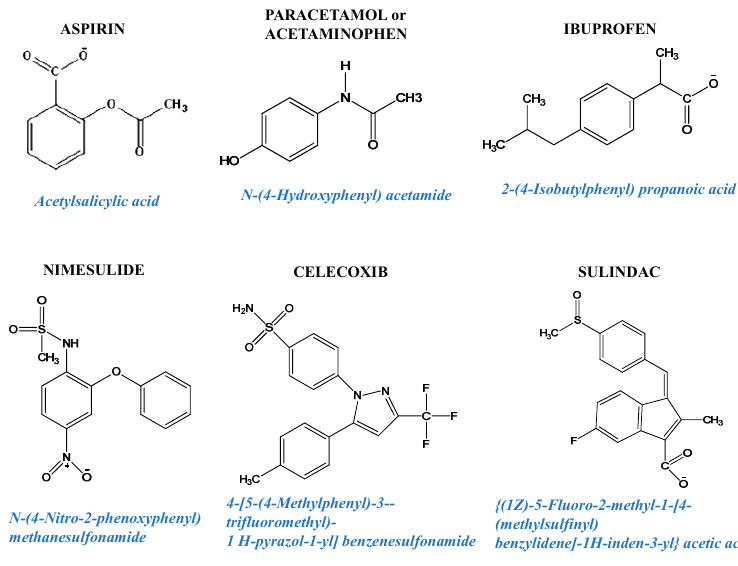
Figure 2. Examples of non-steroidal anti-inflammatory drugs (NSAIDs) chemical